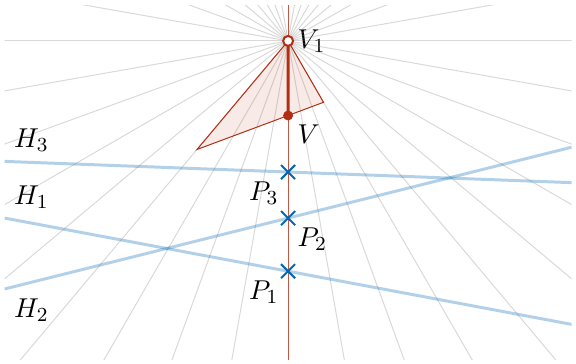
Figure 5 . Configuration for the integral on a specific CP 1 fibre. The contour is induced by intersecting the fibre with the original contour. The singularity points are induced by intersecting the fibre with the original singularity